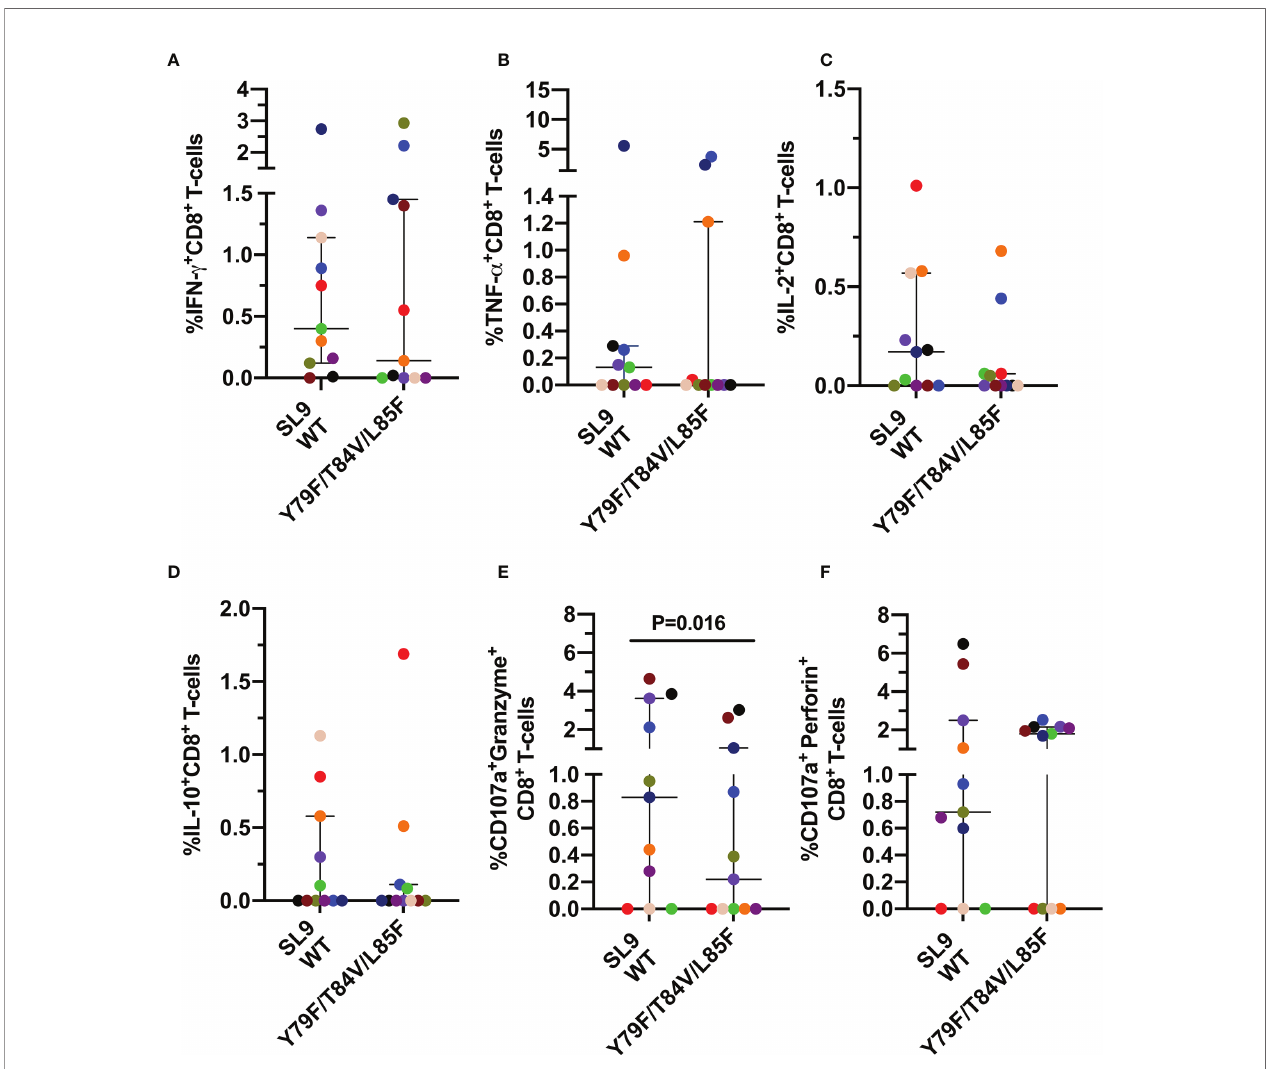
FIGURE 5 | Cytokine mediated and cytotoxic CD8 + T-cell response to SL9 WT and Y79F/T84V/L85F. Frequency of CD8 + T-cells positive for IFN- g (A) , TNF- a (B) , IL-2 (C) , IL-10 (D) , CD107a co-expressed granzyme B (E) or CD107a co-expressed perforin (F) . Each point represents the CD8 + T-cell response in an individual to each peptide (10 µg/mL) after subtraction of the negative control. Wilcoxon test was used for matched-paired samples. Plots depict the median and IQR, n =